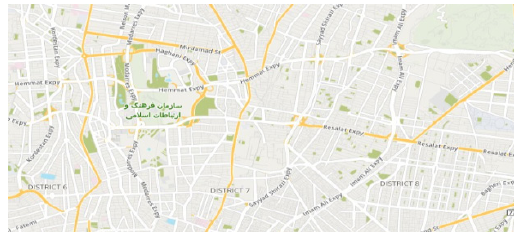
Figure 3: Saving streets Traffic Information